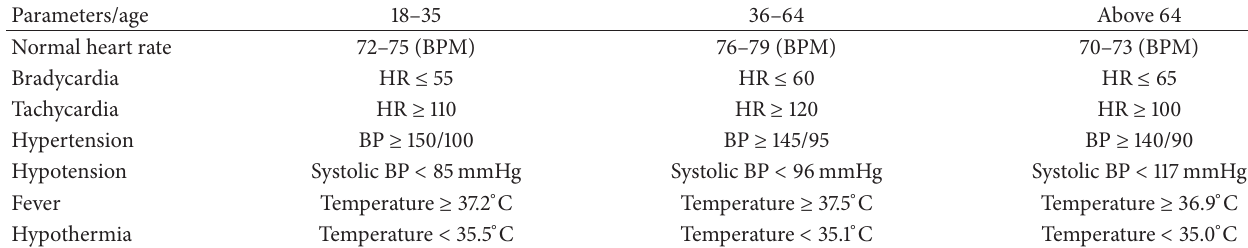
Table 2: Age-wise threshold values for adaptive alarming mechanism.